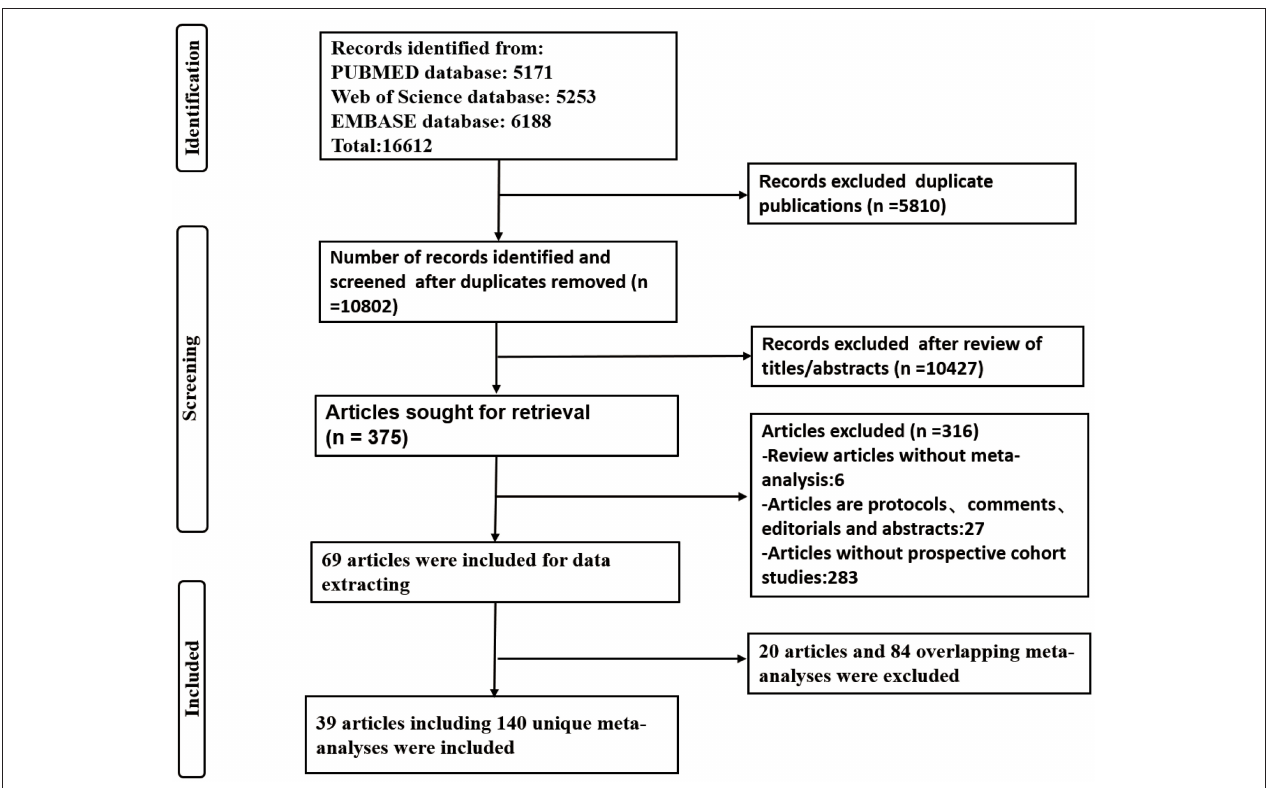
FIGURE 1 | Flow diagram of literature search and study